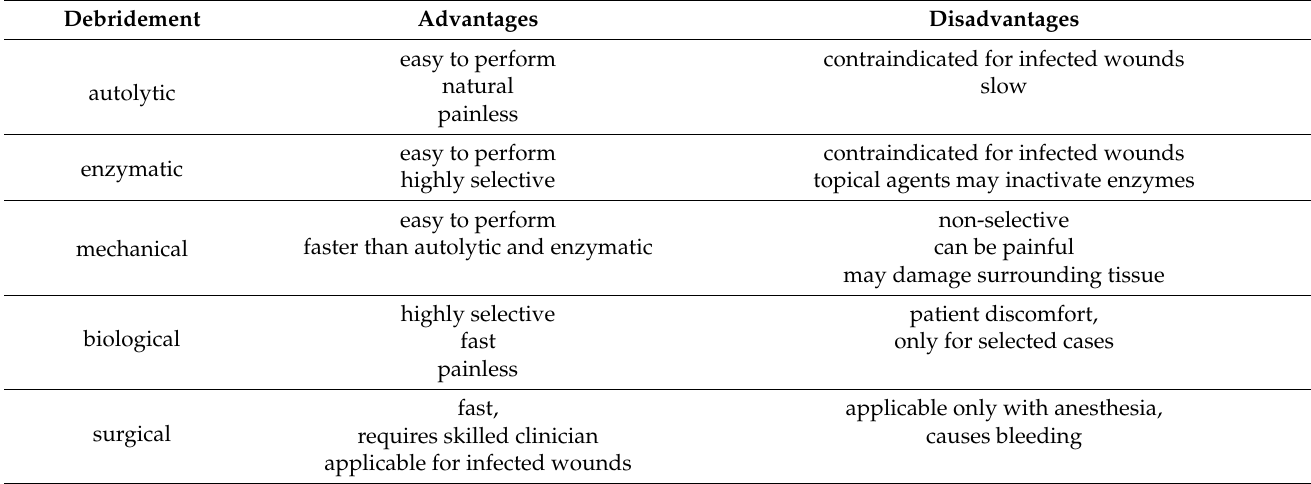
Table 2. Different types of debridement: advantages and